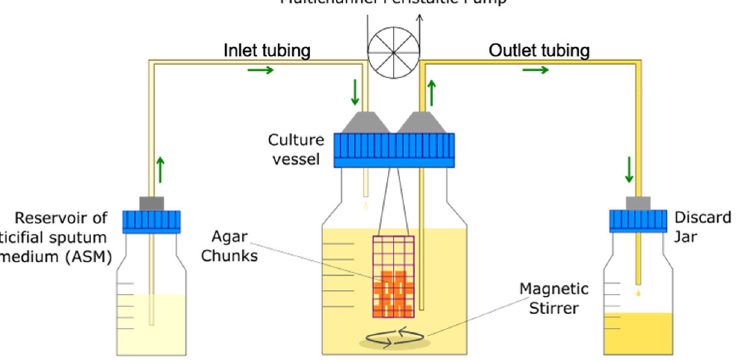
Figure 1. Schematic diagram of the continuous-flow culture vessel containing biofilm container. The main culture vessel (centre) is a 100 mL Duran bottle fitted with a 4-port HPLC GL80 screwcap lid, containing four sealable inlet/outlet ports from which the biofilm container is suspended. A multichannel peristaltic pump delivers fresh media (ASM) into the culture vessel from a reservoir (left), and also removes waste culture into a discard jar (right) at the same rate of flow ( Q ). Arrows show the direction of media flow. The culture vessel and media reservoirs are incubated at 37 ° Cand the contents are kept homogenous through gentle stirring (100 rpm). The value of Q depends on the microbial species being cultured within the vessel.